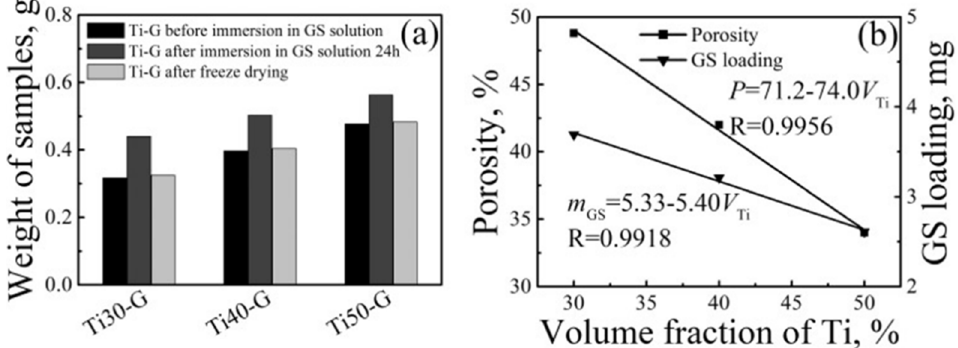
Figure 17. ( a ) Weights of the Ti-G samples before and after immersion in GS solution 24 h, and weights after lyophilization; ( b ) the amounts of the loaded GS and the porosities of GS-loaded Ti-G composites [67] . Reprinted with permission from ref. [67] . © 2021 Elsevier.